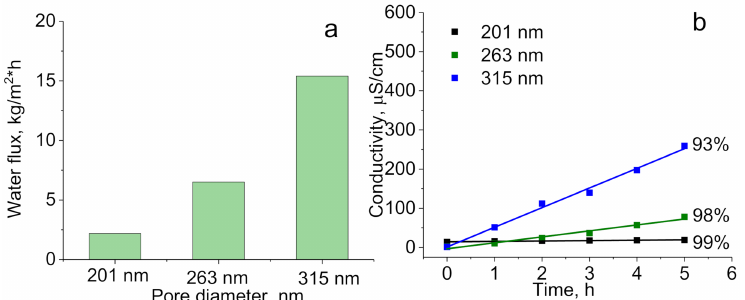
Figure 10. MD water flux ( a ) and electrical conductivity during continuous DCMD tests ( b ) using hydrophobized membranes (PET-Si-F) with di ff erent pore sizes (NaCl 30 g / L, temperature 70 ◦ C). The average water flux for membranes with e ff ective pore diameter (measured by gas permeability) of 210 nm is 2.2 kg / (m 2 · h), 263 nm; 6.5 kg / (m 2 · h) and 315 nm; 15.4 kg / (m 2 · h). The increase in water